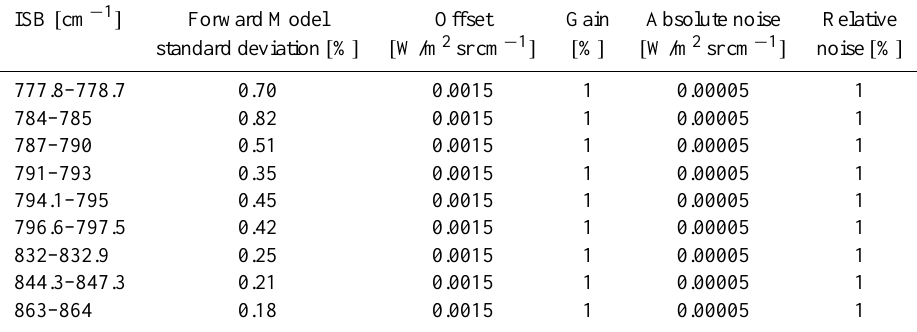
Table 5. Radiance